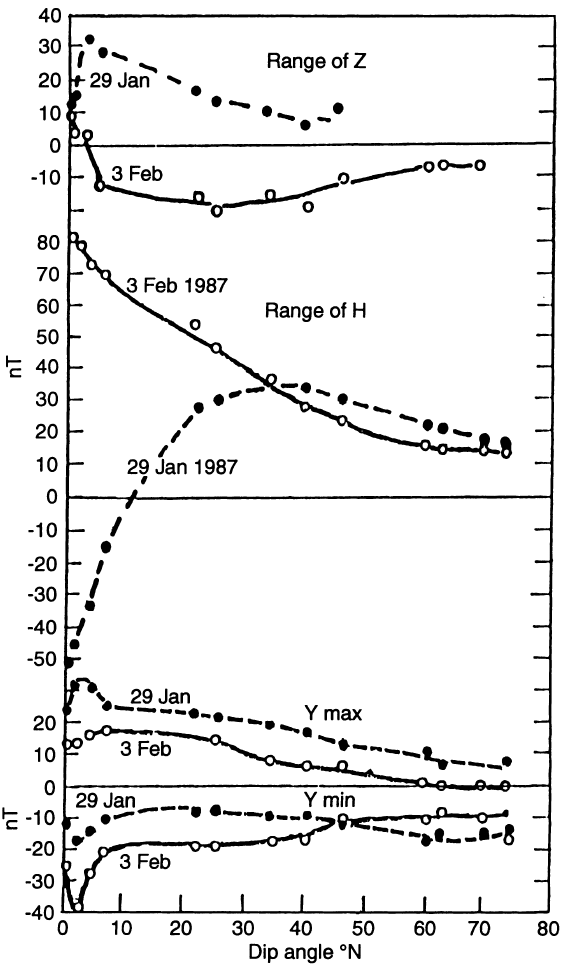
Fig. 6. Latitudinal variations of the ranges of H , Z and Y fields on 29 January and 3 February, 1987